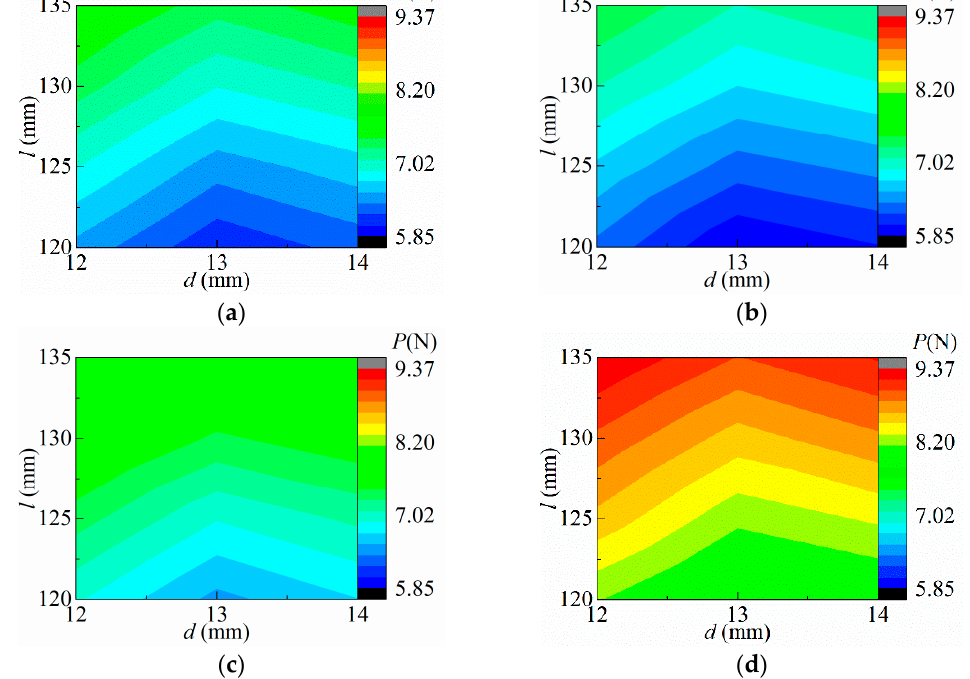
Figure 7. The simulation data of 𝐹 𝑆 to correspond to each group of tests: ( a ) 𝜃 = 21°; ( b ) 𝜃 = 24°; ( c ) 𝜃 = 27°; ( d ) 𝜃 = 30°.